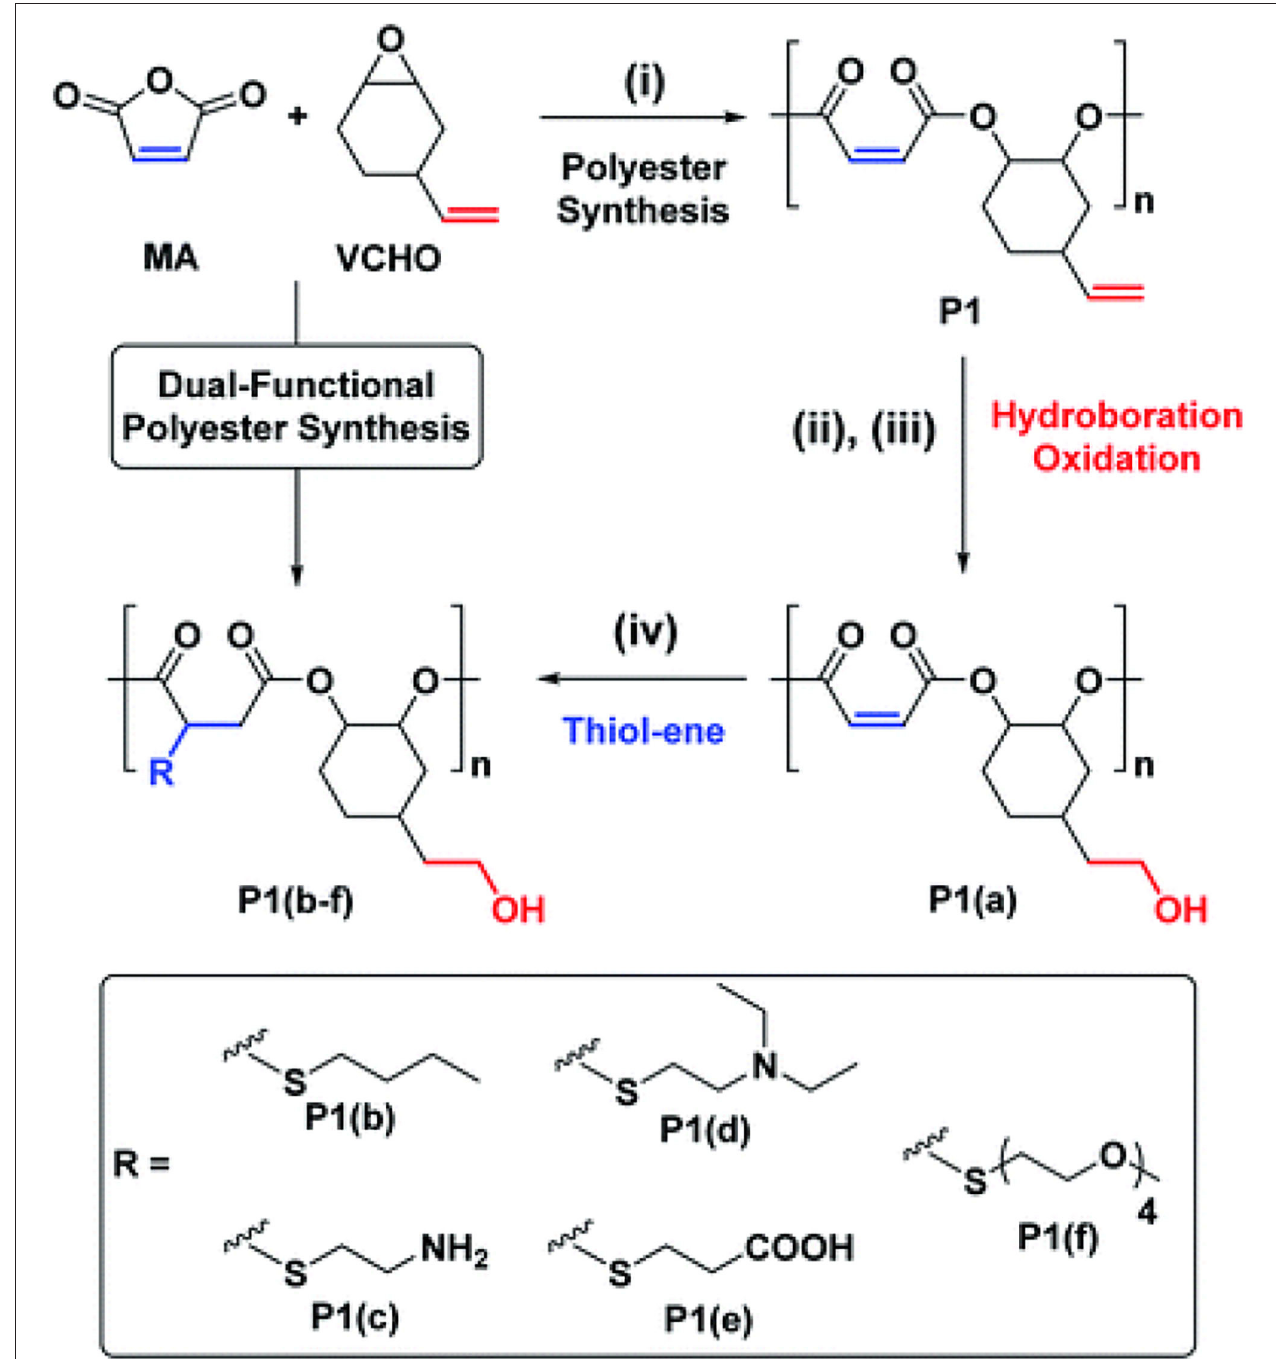
FIGURE 11 | Selective synthesis of dual-functional alternating polyesters (using a combination of MA and VCHO as a representative example). Adapted with permission from Yi et al. (2019). Copyright 2019 The Royal Society of